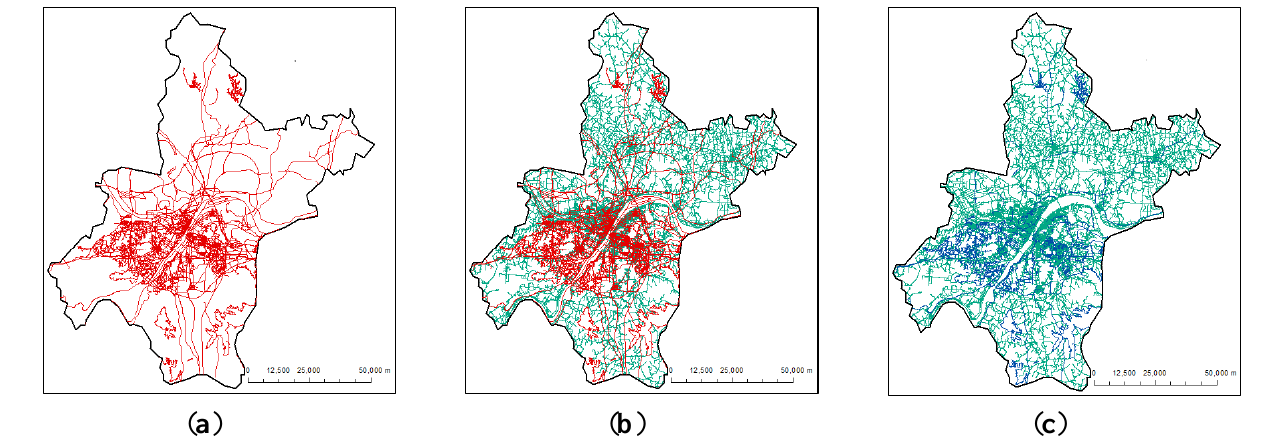
Figure 10. OSM roads (red), reference roads (green), and detected new roads (blue) for the Wuhan dataset. ( a ) OSM roads; ( b ) OSM atop the reference roads; ( c ) Detected new roads atop the reference roads.